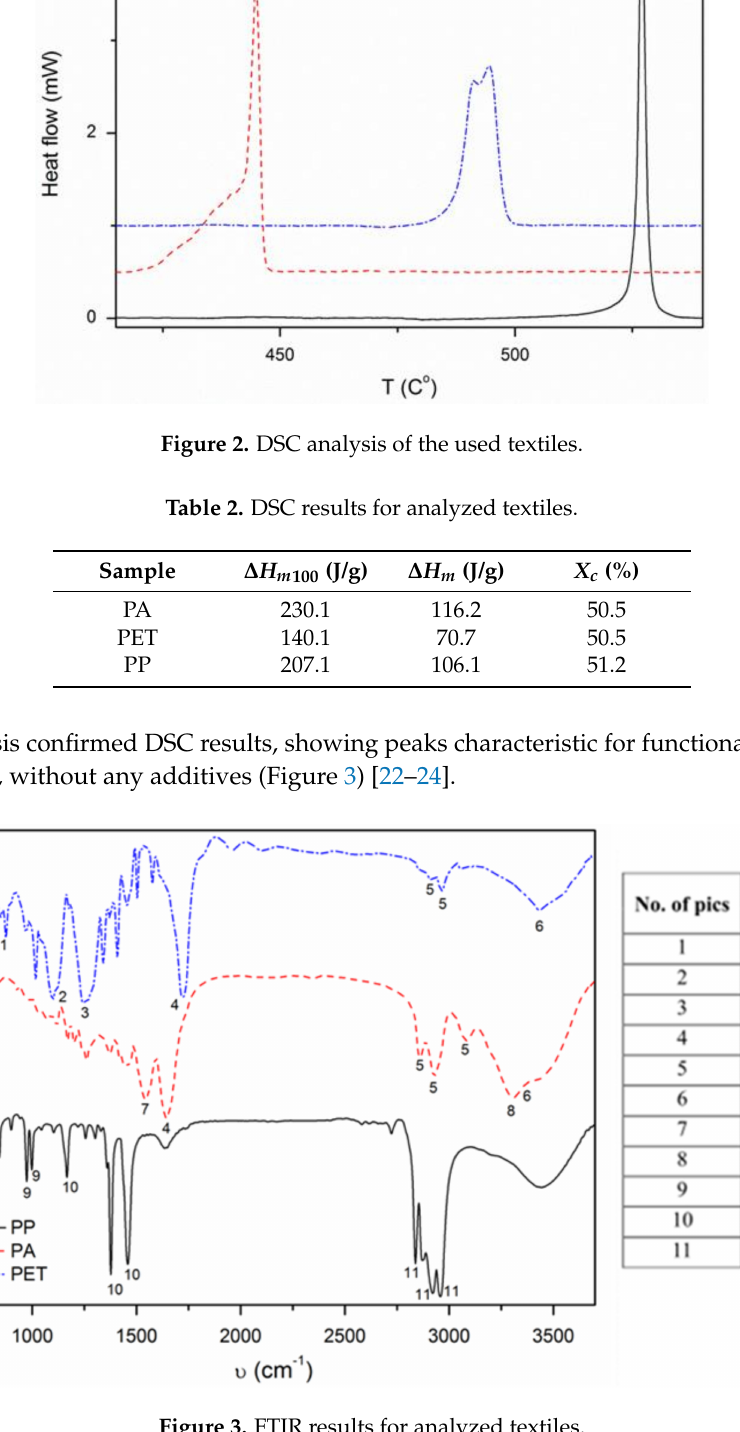
Figure 3. FTIR results for analyzed